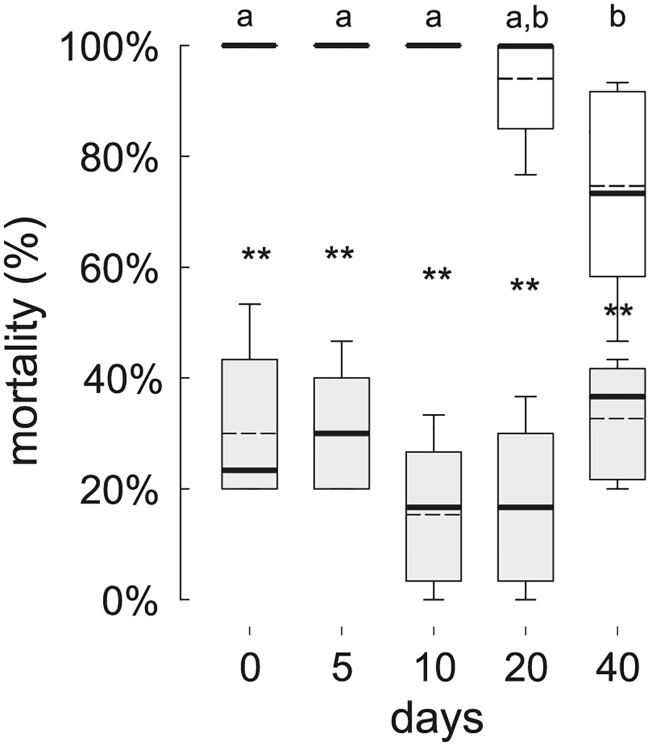
Mortality of 3rd instar Cx. quinquefasciatus after transfer to water bodies with different post-SPLAT application periods.Grey box plots indicate the mortality values obtained for the control (SPLATblank), while the white box plots represent those for the treatment (SPLATbac 10−1). Different letters indicate significant differences (Dunn’s pairwise multiple comparisons, p < 0.05) between SPLATbac post-application periods. Asterisks indicate significant differences between SPLATbac and SPLATblank treatments from the same post-application day (** = p < 0.01).